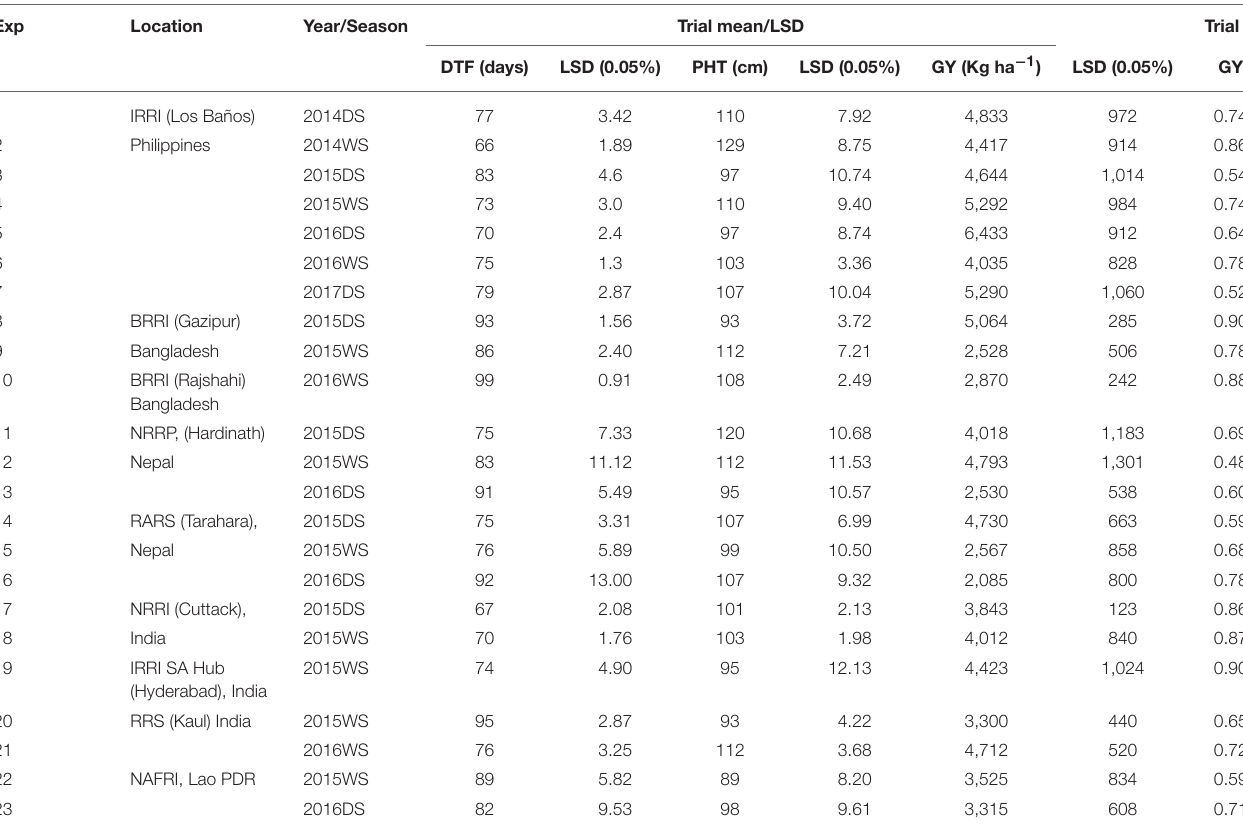
TABLE 3 | Descriptive agronomic traits statistics across different ecosystems, seasons, and years under aerobic conditions.